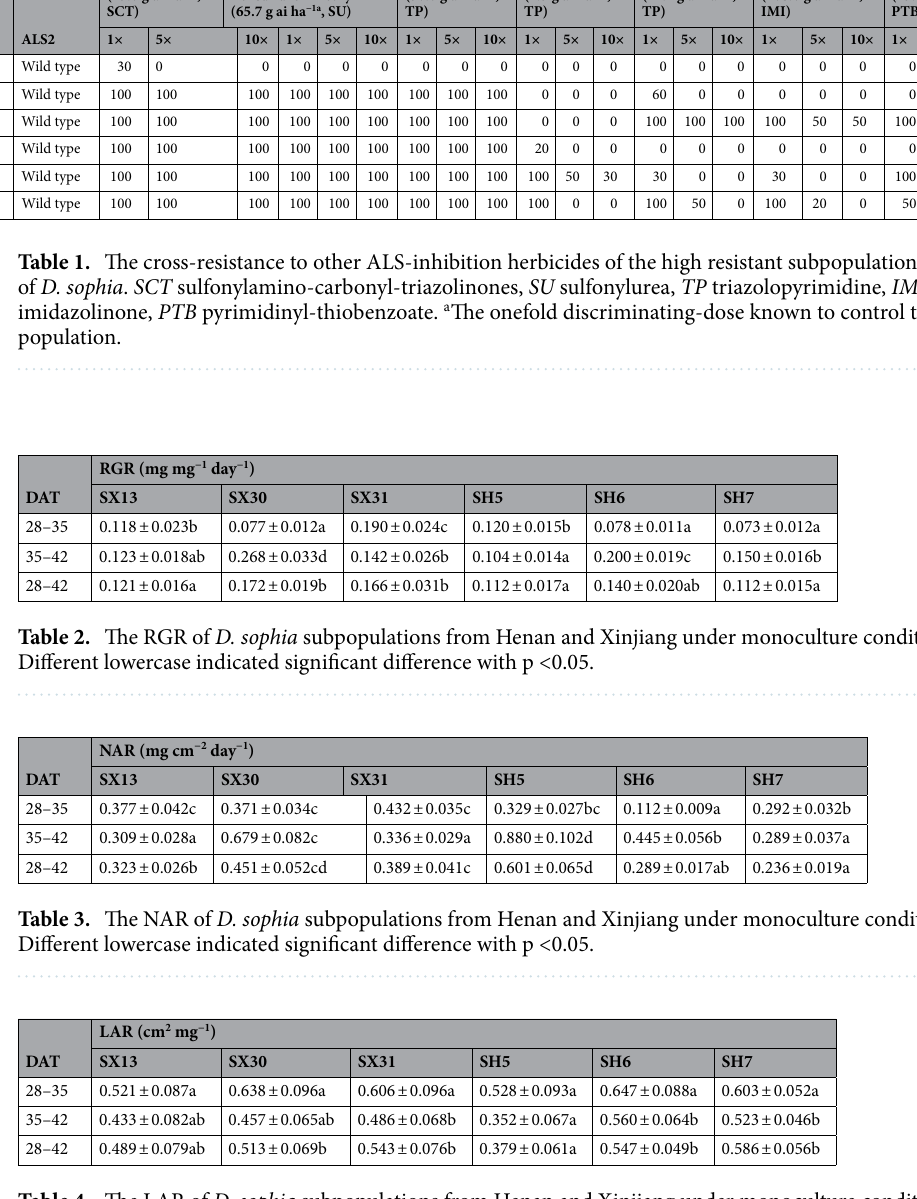
Table 4. The LAR of D. sophia subpopulations from Henan and Xinjiang under monoculture condition. Different lowercase indicated significant difference with p